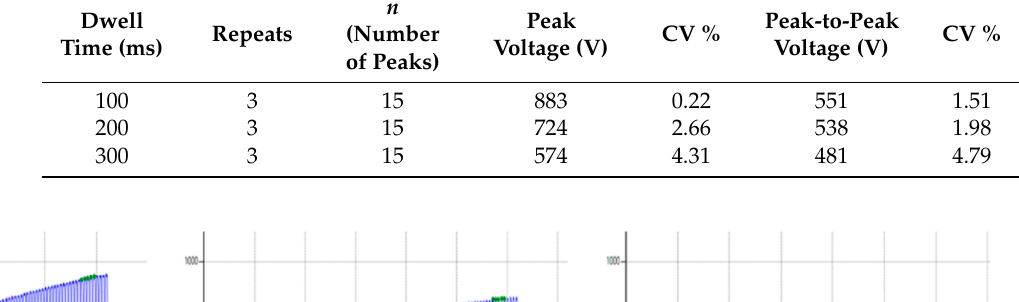
Table 5. The effect of the dwell time on the electrostatic charge generation.